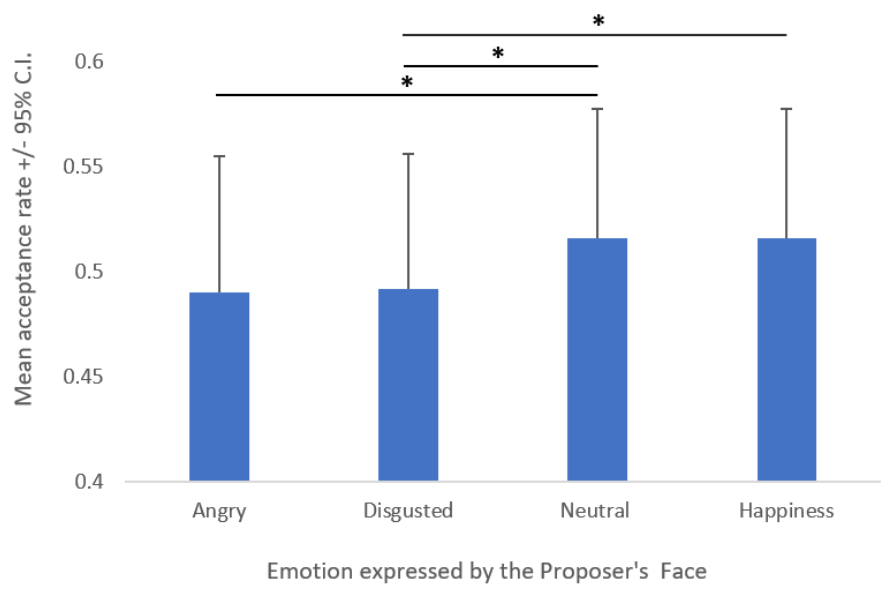
Figure 2. Main effect of the emotion expressed by the proposer’s face on the mean acceptance rate. Asterisks (*) indicate significant post hoc comparisons.